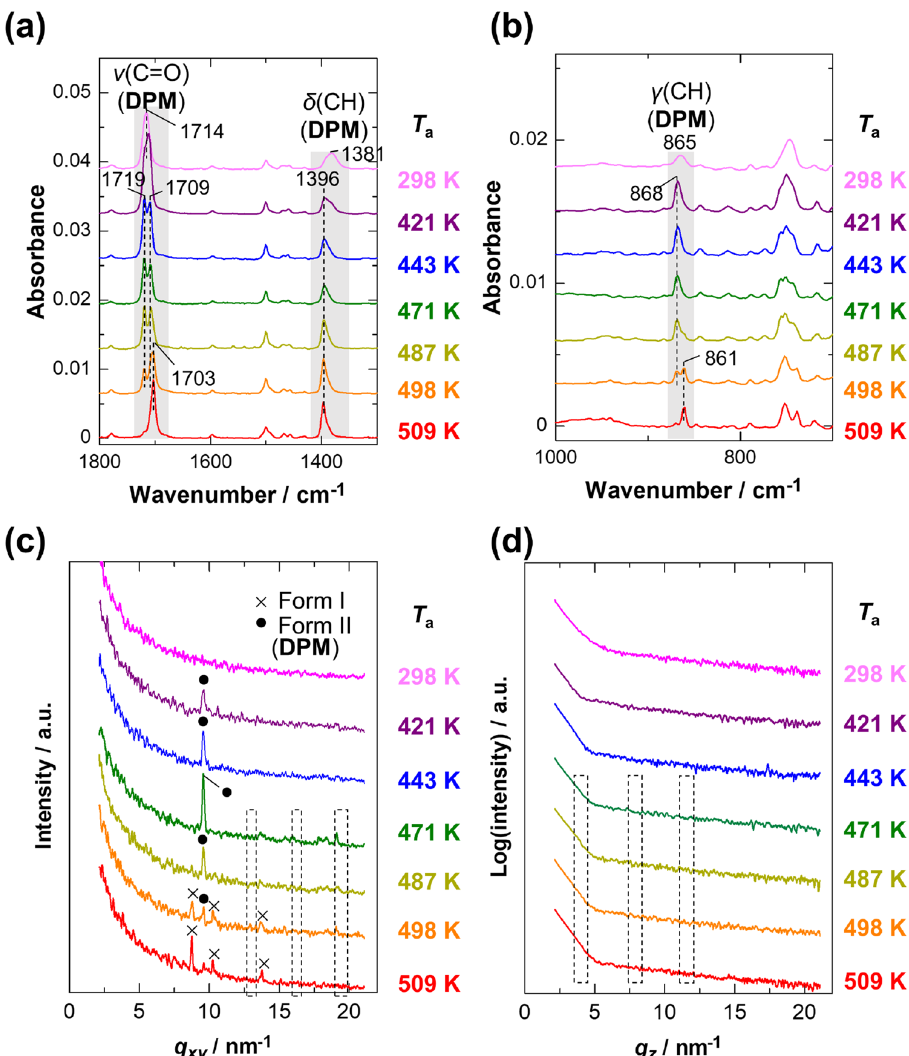
Figure 4. Orientation-free IR spectra ( a , b ), GIXD patterns ( c ), and specular XRD patterns ( d ) of exo-DPM thin films annealed for 10 min as a function of annealing temperature ( T a ). The areas enclosed by dashed lines in the diffraction patterns indicate the peak positions of